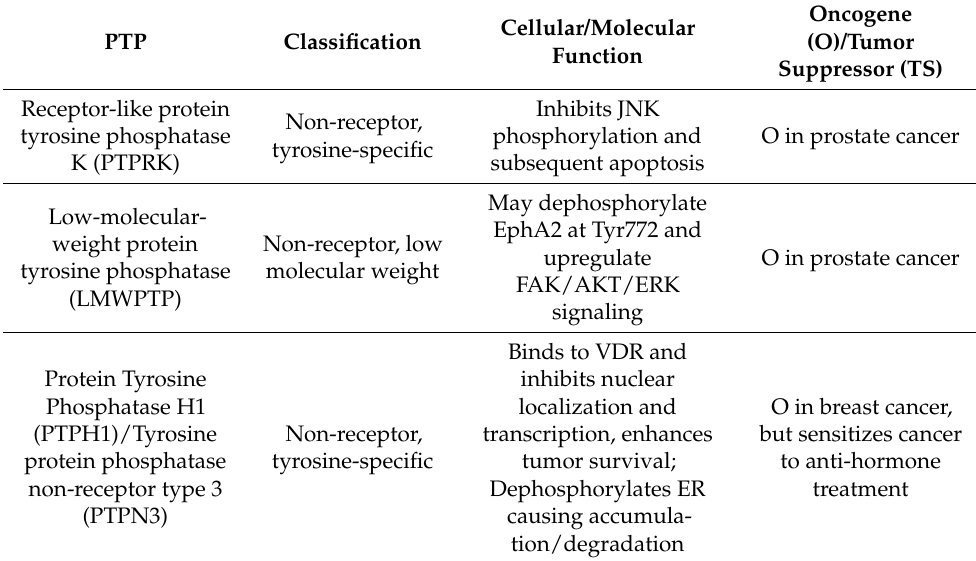
Table 4. PTPs that influence related